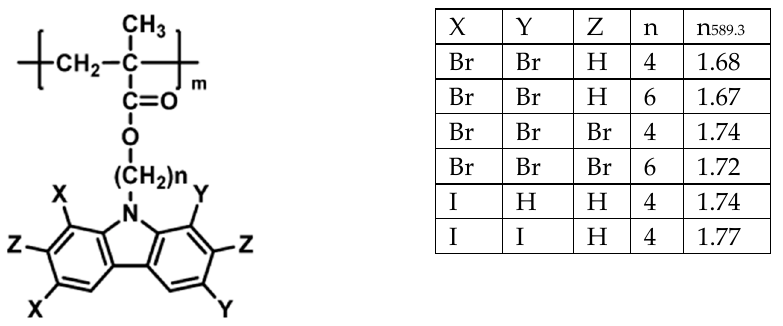
Figure 25. Halogen substituted polymethacrylates structure and values of refractive index [250,251].